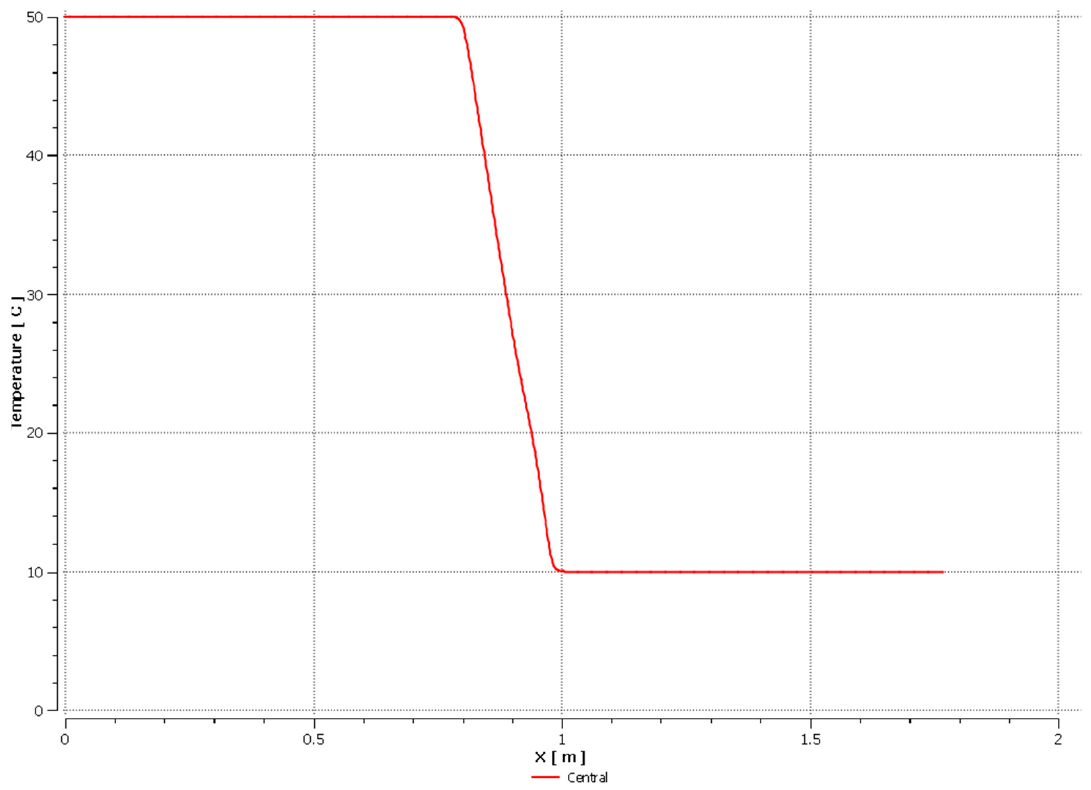
Figure 4. Temperature distribution along the height of the heat pipe’s central line.